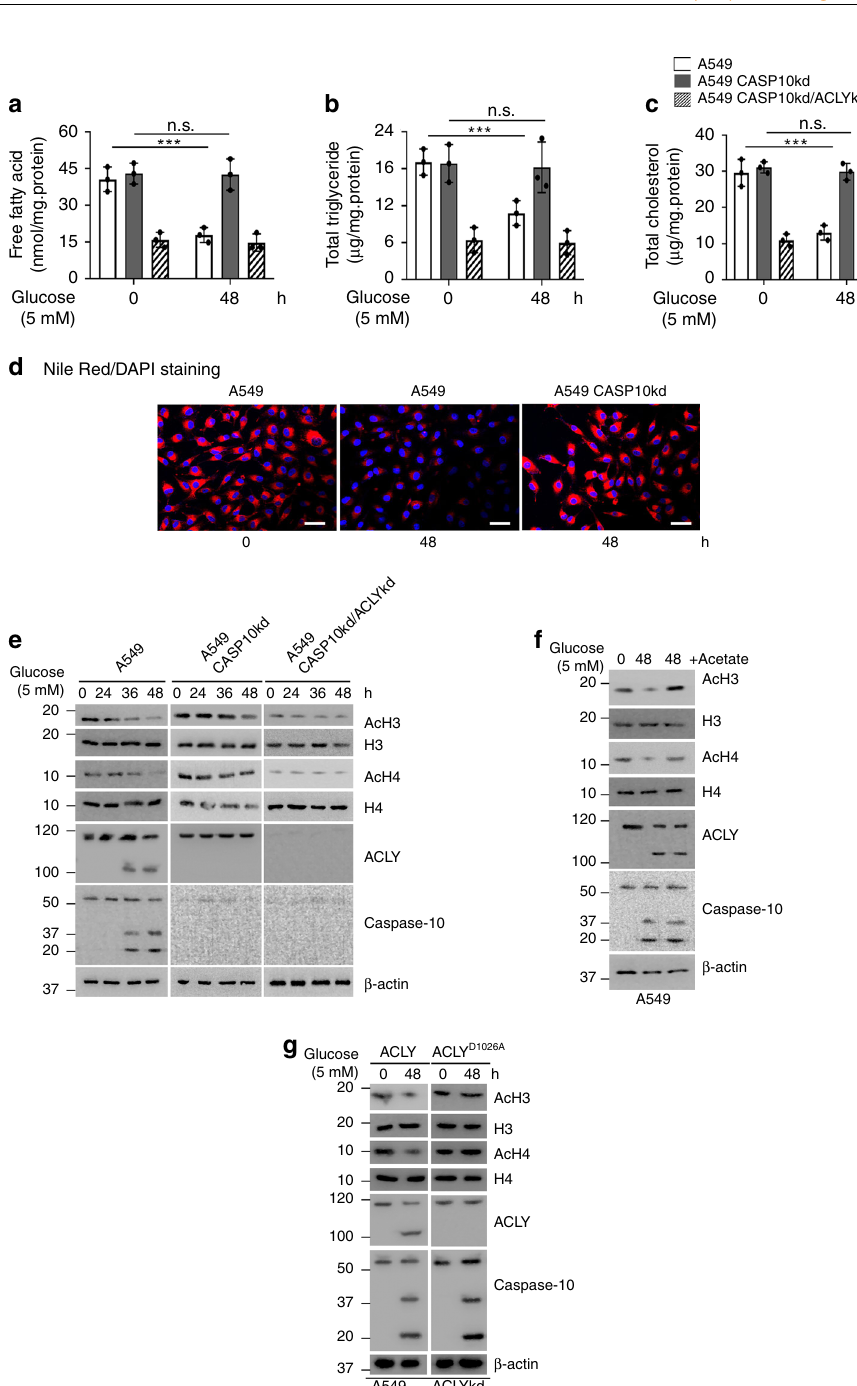
Fig. 4 Caspase-10 downregulates intracellular lipid levels and histone acetylation a – c A549 cells were stably transfected (pooled zeocin-resistant population) with control (scrambled), caspase-10 shRNA or caspase-10 shRNA along with ACLY shRNA. A549 control (A549), CASP10 knockdown (A549 CASP10kd) and CASP10/ACLY double knockdown (A549 CASP10kd/ACLYkd) cells were subjected to glucose starvation for the indicated time points followed by ( a ) free fatty acids quanti fi cation, ( b ) total triglycerides quanti fi cation, and ( c ) total cholesterol quanti fi cation. Error bars are means ± SD of three biological replicates. Statistical analyses were done using two-way ANOVA (Bonferroni ’ s post hoc test). *** P < 0.001. d A549 cells were subjected to glucose starvation for 48 h and treated with caspase-10 inhibitor, Q-AEVD-FMK (25 μ M) or palmitate (0.2 mM) for last 24 h of starvation period. The cells were then stained with Nile Red (5 μ g/ml) and examined. DAPI was used to counterstain the nucleus. Scale bar: 50 μ m. e A549 control (A549), caspase-10 knockdown (A549 CASP10kd) and caspase-10/ACLY double knockdown (A549 CASP10kd/ACLYkd) cells were subjected to glucose starvation for the indicated time points. The cells were then harvested and western blotting was performed for the indicated proteins. f A549 cells were subjected to glucose starvation for 48 h and treated with sodium acetate (5 mM) for the last 24 h of starvation period. The cells were then harvested and western blotting was performed for the indicated proteins. g A549 ACLY knockdown cells (A549 ACLYkd) were stably transfected with wild-type ACLY (ACLY) or caspase-10-cleavage resistant mutant (ACLY D1026A ). These cells were subjected to glucose starvation for the indicated time points. The cells were then harvested and western blotting was performed for the indicated proteins. Source data are provided as a Source Data fi